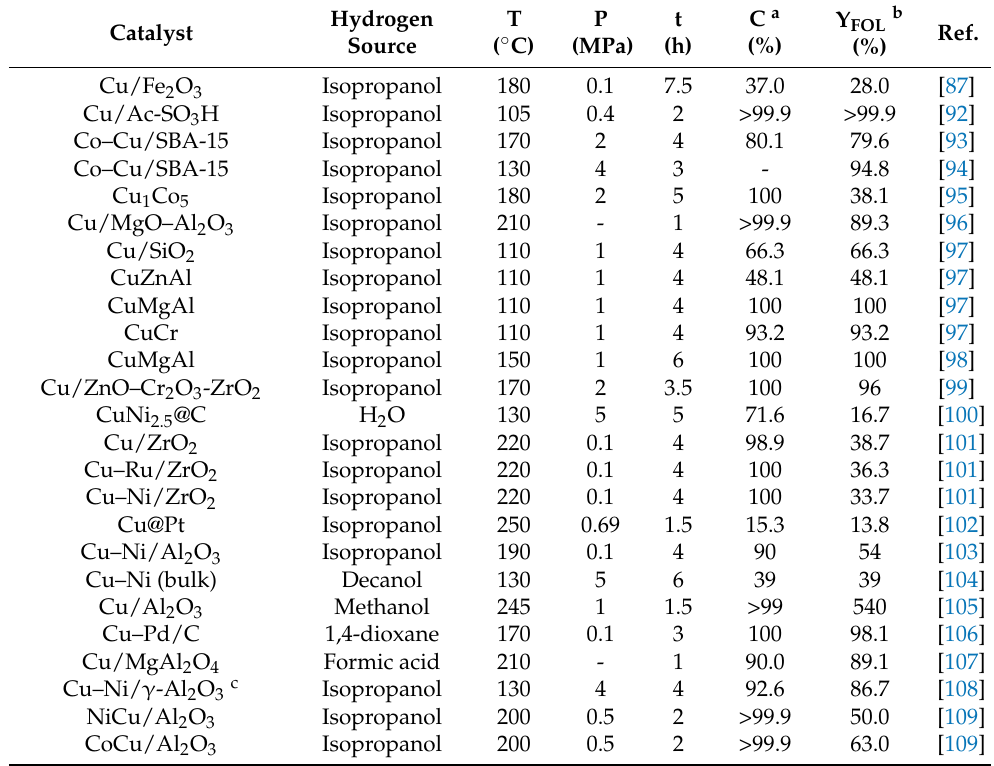
Table 2. Catalytic activity of Cu-based catalysts for conversion of FUR to FOL through